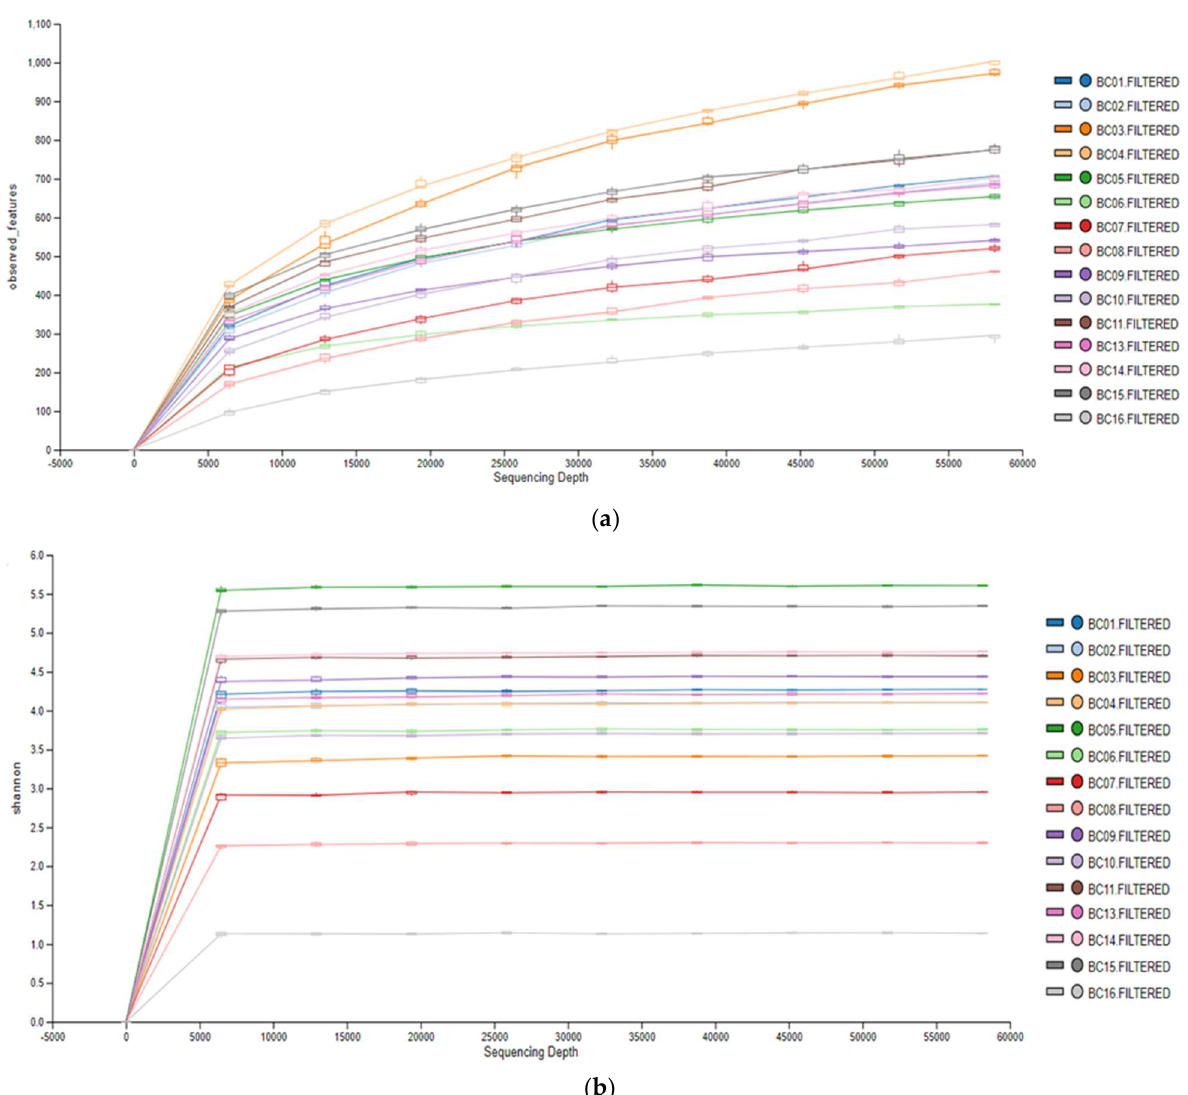
Figure 1. Alpha rarefaction curves of all samples at the genus level: ( a ) the sequencing depth in relation to the observed features and ( b ) the sequencing depth in relation to Shannon index.